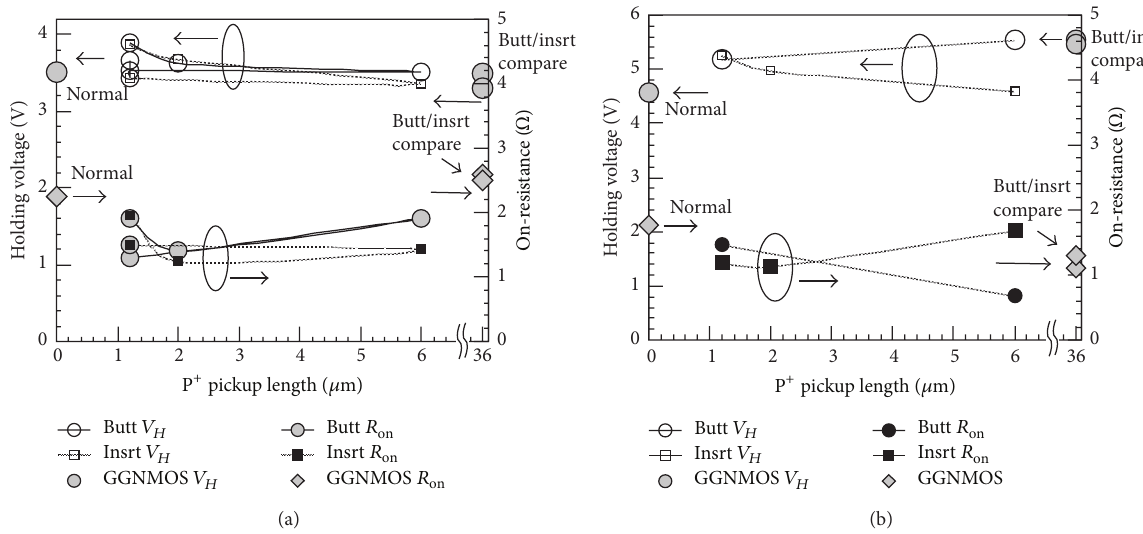
Figure 5: (a) The holding voltage and on-resistance comparison among the 1.8 V GGNMOS and various butting/inserted pickup styles with respect to the pickup length. (b) The holding voltage and on-resistance comparison among the 3.3 V GGNMOS and various butting/inserted pickup styles with respect to the pickup